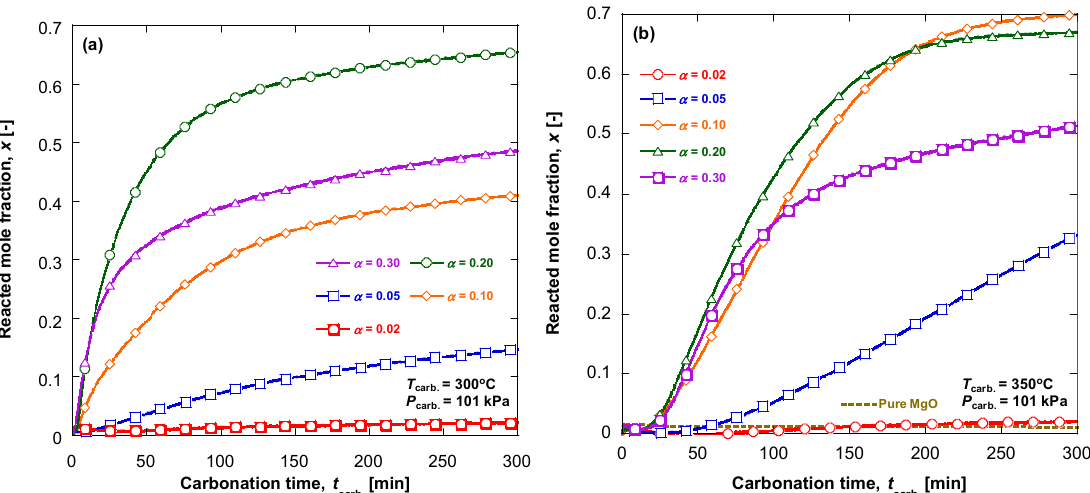
Figure 3. Carbonation dynamics of the (LiK)NO 3 / MgO composites: isothermal experimental results at ( a ) 300 ° C and ( b ) 350 ° C under P (CO 2 ) = 101 kPa.